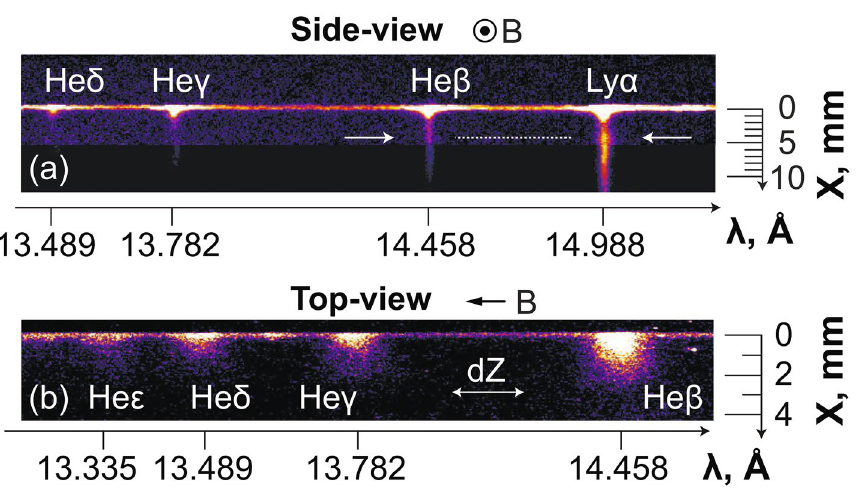
Figure 6. ( a ) Image of the X-ray emission analyzed by the FSSR spectrometer of the laser-induced plasma expansion inside the transverse magnetic field of 30 T strength. What is seen is the spectrally resolved image 4 mm. ( b ) of the plasma in the XY plane. Arrows demonstrate the increase in emissivity in the spatial region ∼ FSSR X-ray raw image showing similar spectral range as in ( a ), but when probing the plasma along a different line of sight, here along the Y-axis of plasma expansion (see Fig. 1). Hence what is seen is the spectrally resolved image of the plasma in the XZ plane. The absence of the Ly α line here is due to the different target-to-crystal distance that was changed to 214 mm in order to better observe the 2D dynamics (with higher spatial resolution 1 in meridional plane) of the plasma along Z axis and magnification m =